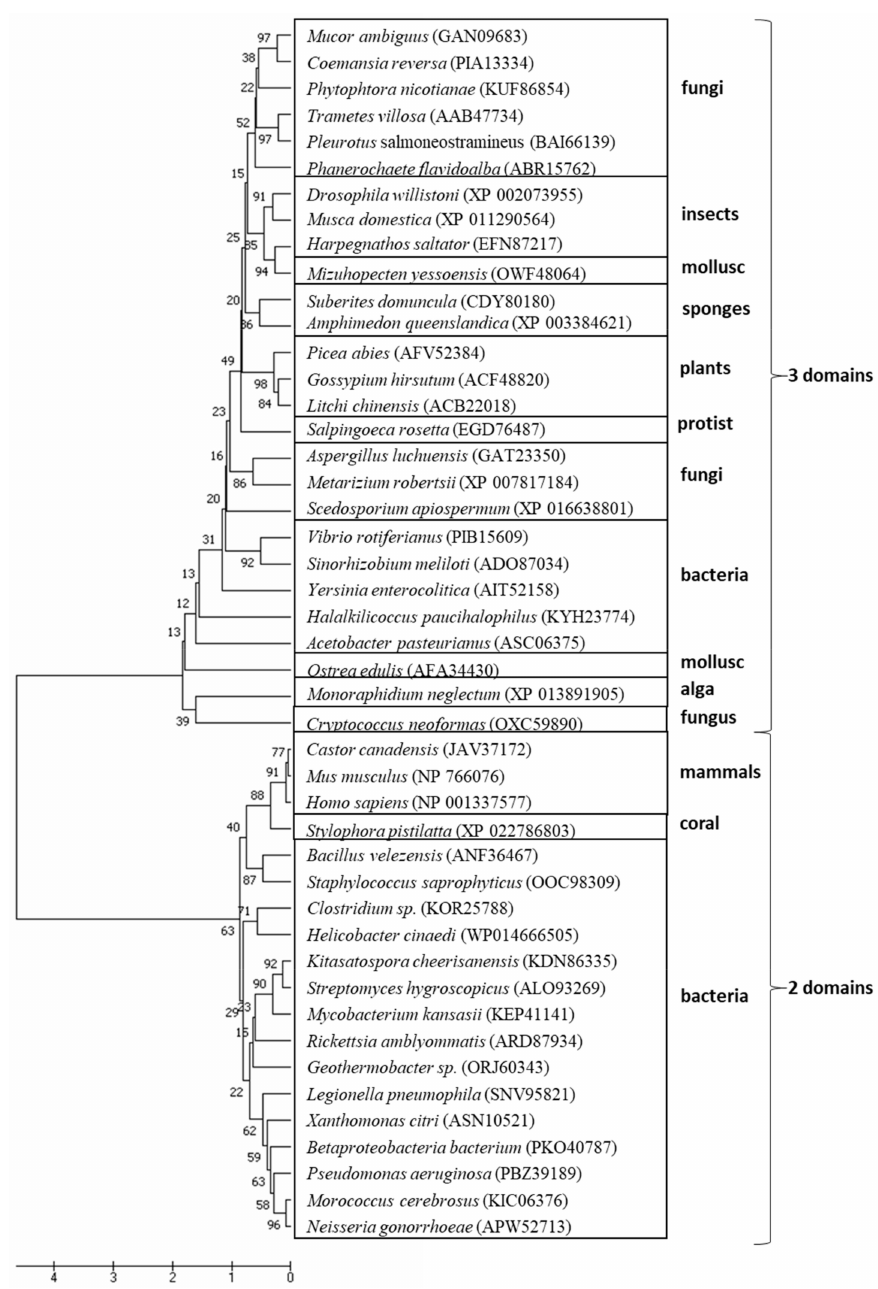
Figure 3. The evolutionary history of laccase was created using the UPGMA method [22]. The optimal tree with the sum of branch length = 38.42825656 is shown. The percentage of replicate trees in which the associated taxa clustered together in the bootstrap test (1000 replicates) is shown next to the branches [23]. The tree is drawn to scale, with branch lengths in the same units as those of the evolutionary distances used to infer the phylogenetic tree. The evolutionary distances were computed using the Dayho ff matrix based method [24] and expressed in the units of the number of amino acid substitutions per site. The analysis involved 46 amino acid sequences. All positions containing gaps and missing data were eliminated. In total, there are 72 positions in the final dataset. The evolutionary analyses were conducted in MEGA7